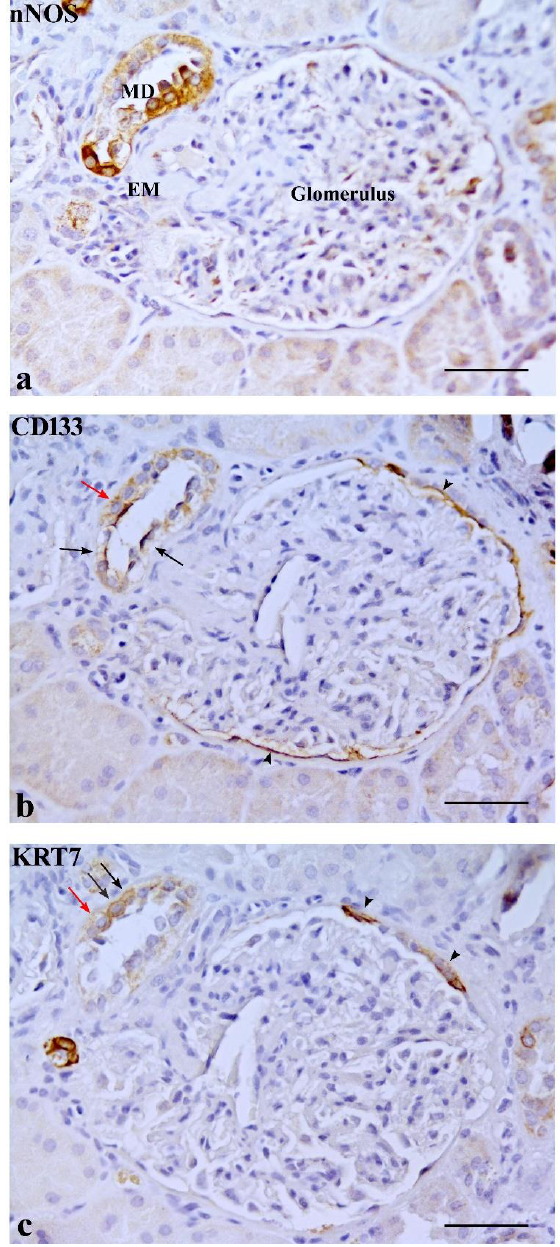
Figure 2. Three serial sections of the same macula densa (MD) stained with nNOS ( a ), CD133 ( b ) and cytokeratin 7 (KRT7) ( c ). ( b ) Some CD133-positive cells are localized in both MD and adjacent DT cells (arrows). The parietal epithelium of the Bowman’s capsule is also positive (positive internal control) (arrowheads). ( c ) KRT7 is localized in three cells (arrows) belonging to DT cells adjacent to MD as well as in two tracts of the parietal epithelium of the Bowman’s capsule (arrowheads). A cell of the DT co-expresses both CD133 and KRT7 markers (red arrows). EM, extraglomerular mesangium. Scale bar: 50 µm.